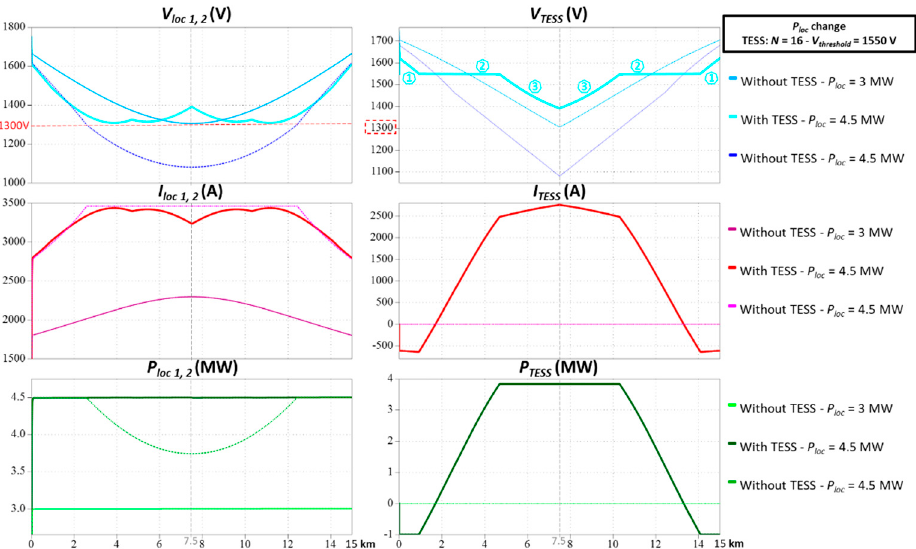
Figure 8. Simulation results according to the location of the crossing point of locomotives 1 and 2 in the sector. A total of 3 case studies: P loc = 3 MW—without TESS, and P loc = 4.5 MW—with and without